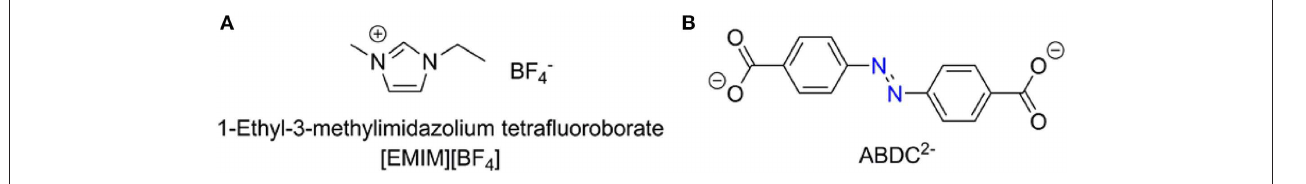
Frontiers in Materials |